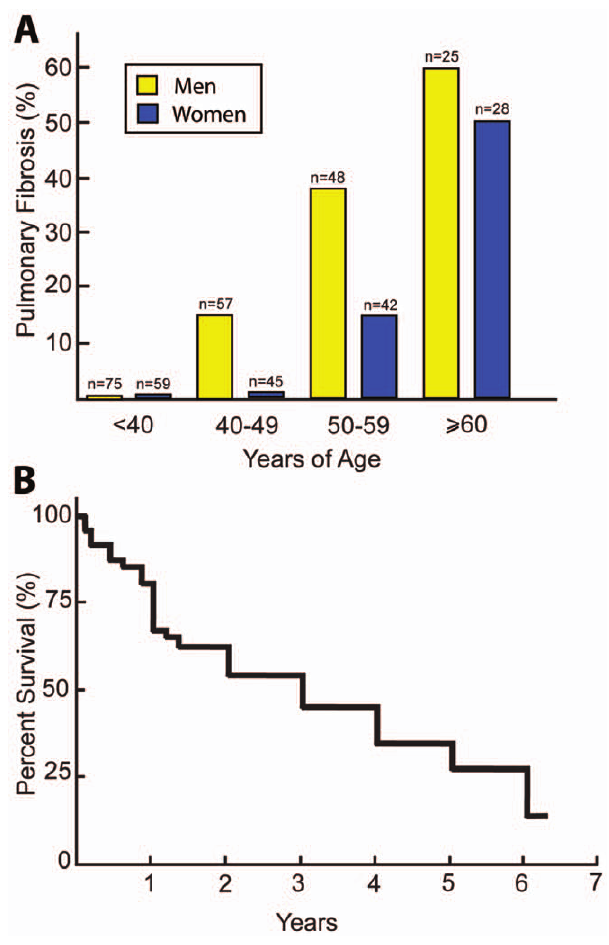
Figure 4. Pulmonary fibrosis is a lethal, age-associated phenotype of TERT mutation carriers. ( A ) Penetrance of pulmonary fibrosis is shown for men (yellow) and women (blue bars) of different ages. No one less than 40 years of age exhibited pulmonary fibrosis. Penetrance of pulmonary fibrosis for men vs. women 40–49, 50–59 and $ 60 years of age is 14% vs. 2%, 38% vs. 14%, and 60% vs. 50%, respectively. ( B ) Kaplan-Meier survival curve of 47 different TERT mutation carriers with pulmonary fibrosis demonstrate a mean survival of 3 years after diagnosis.